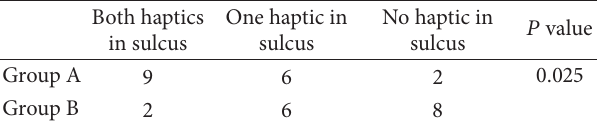
Table 2: Haptic location 3 months after surgery.